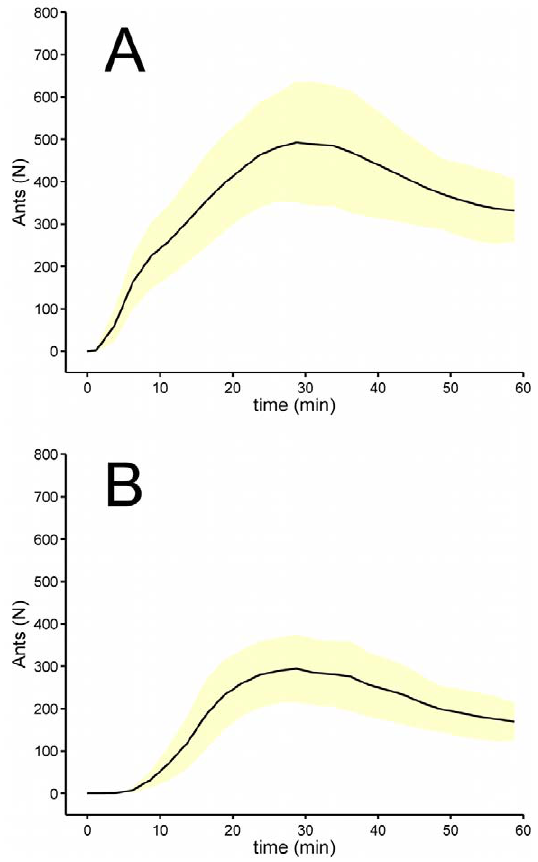
Figure 2. Arena level statistics of exploration. A. Number of ants in the arena over time. B. Number of ants along the arena border (i.e. less than 2.5 cm from the border) over time. For each plot the curve gives the mean and standard deviation over all trials.